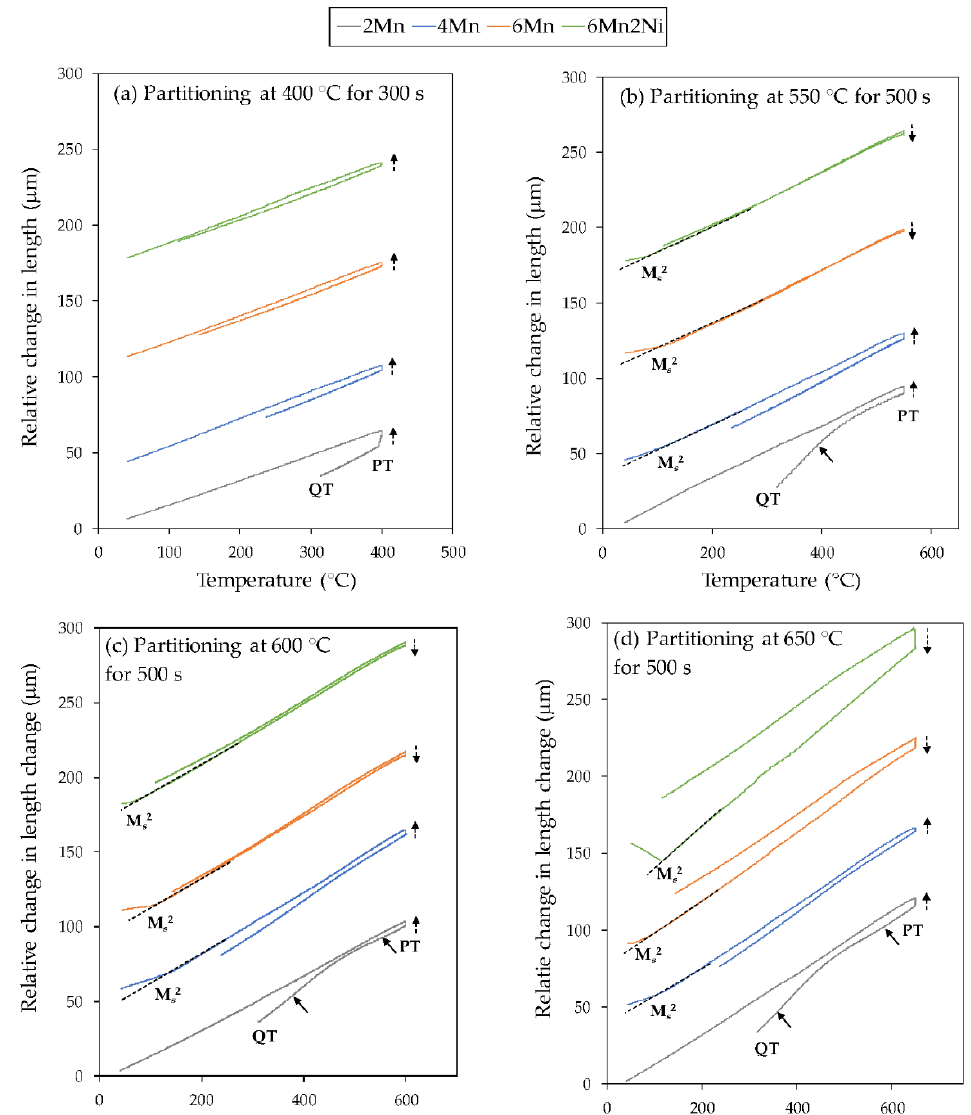
Figure 8. Dilatometry trace for the heating from quenching temperature (QT) to partitioning temperature (PT) in partition treatment at ( a ) 400 °C; ( b ) 550 °C; ( c ) 600 °C; ( d ) 650 °C and final quenching to room temperature. The start of secondary martensite formation in the final cooling is indicated by M s2 .